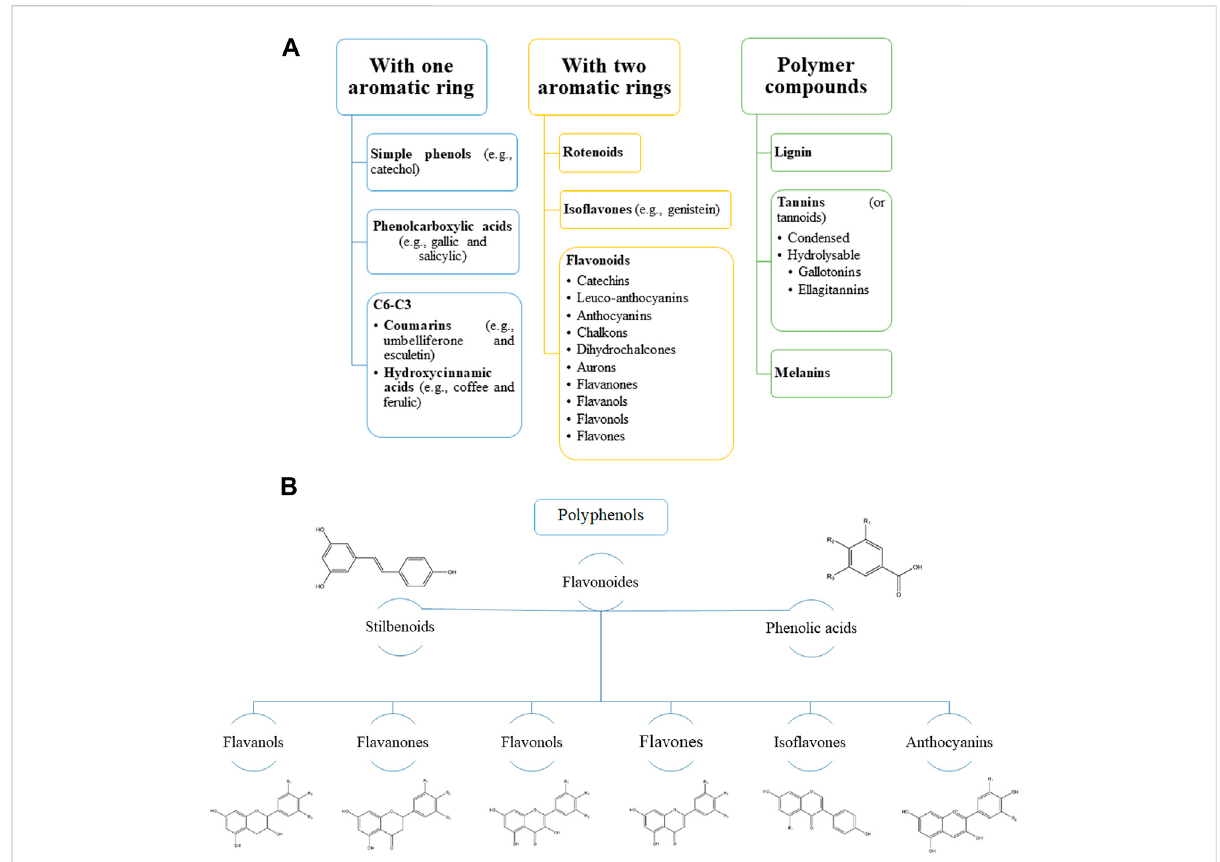
glycosides. Various variations of fl avonoids are linked by a common